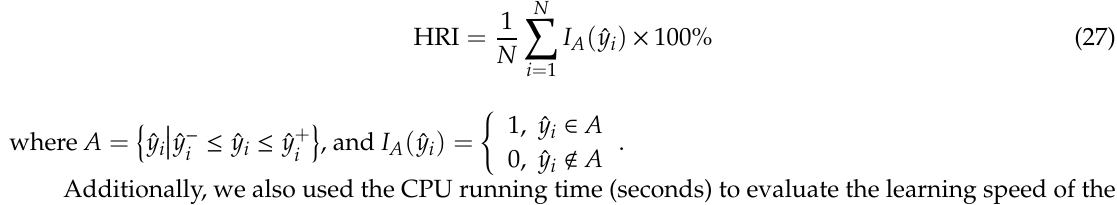
Table 2. E xperimental results for candidate clusters (The best metrics are highlighted in bold).